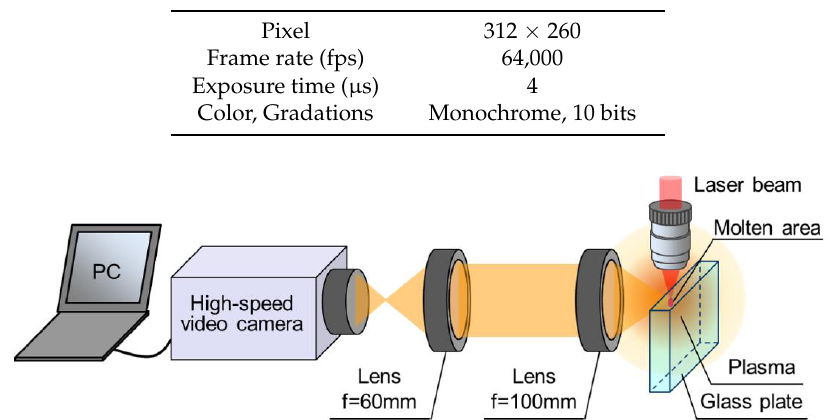
Table 3. Specifications of high-speed video camera.